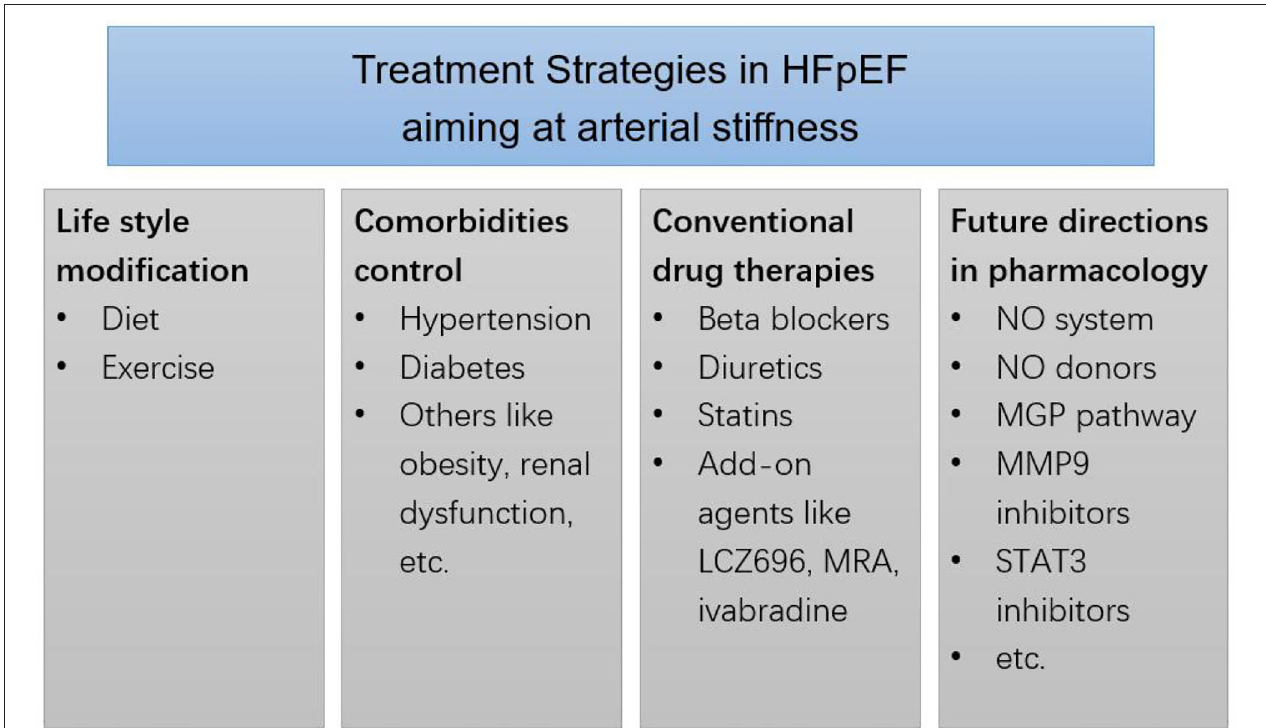
FIGURE 1 | Treatment strategies in HFpEF aiming at arterial stiffness. MRA, mineralocorticoid receptor antagonists. MGP, matrix gla-protein. MMP9, matrix metalloproteinases 9. STAT3, transcription factor signals transducer and activator of transcription